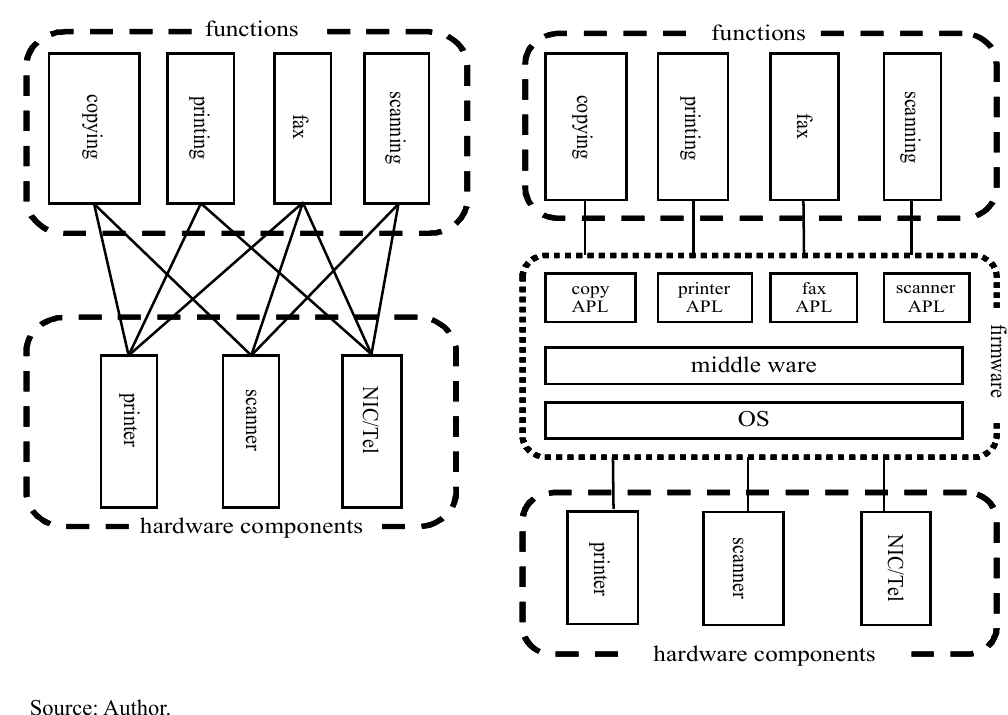
Figure 2. Product architecture of digital